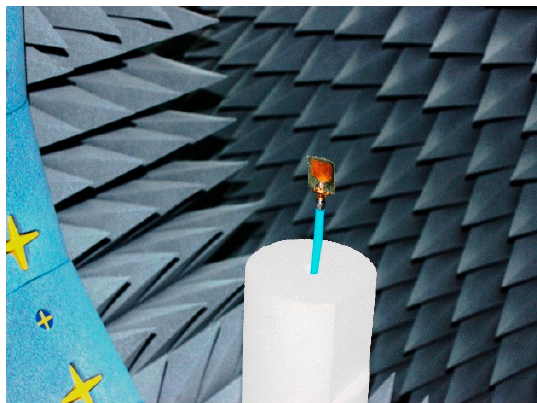
Figure 2. Measurement setup of designed flexible antennas at 42% concentration of nickel in Satimo Star Lab.